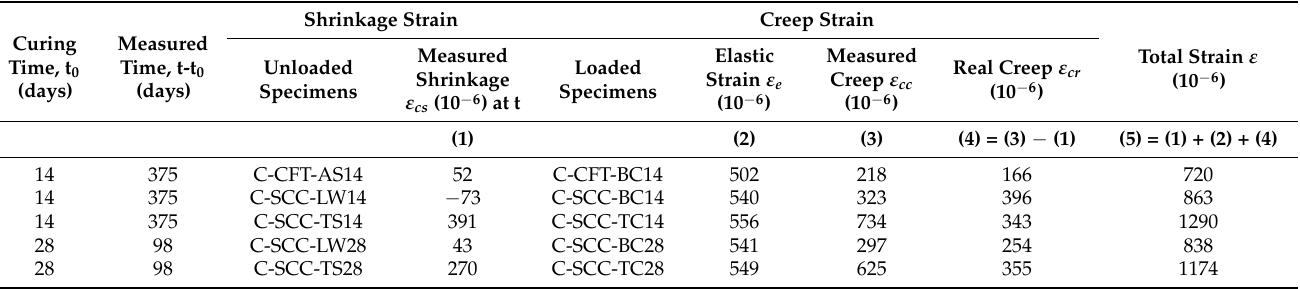
Table 6. Time-dependent deformation of